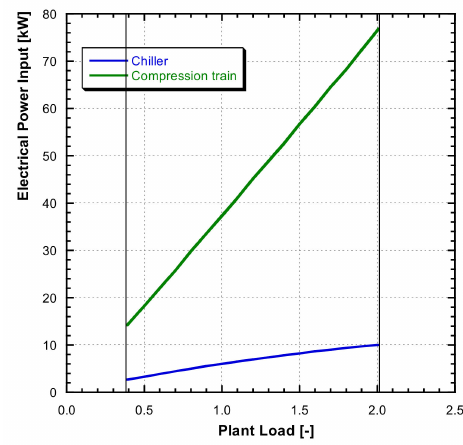
Figure 7. Non dimensional total specific energy consumption and the LNG produced mass flow rate, as a function of the total electrical input.